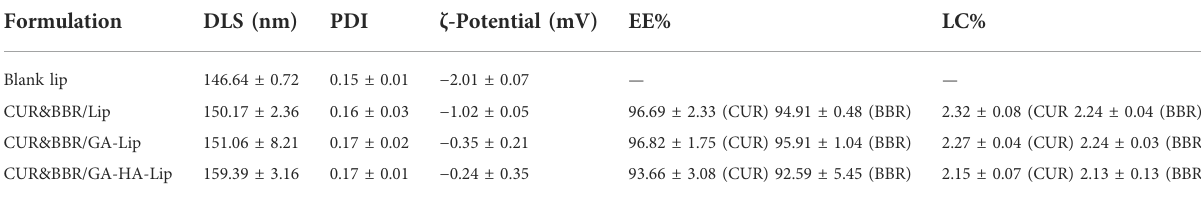
TABLE 1 Characteristics of different liposomal formulations. Formulation